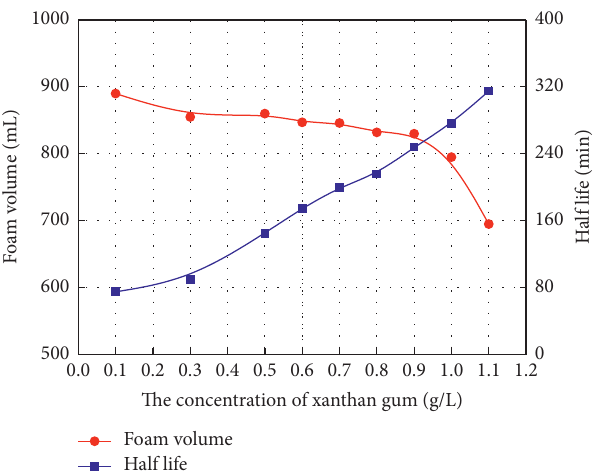
Figure 8: The curve of foaming volume and half-life under different concentrations of xanthan